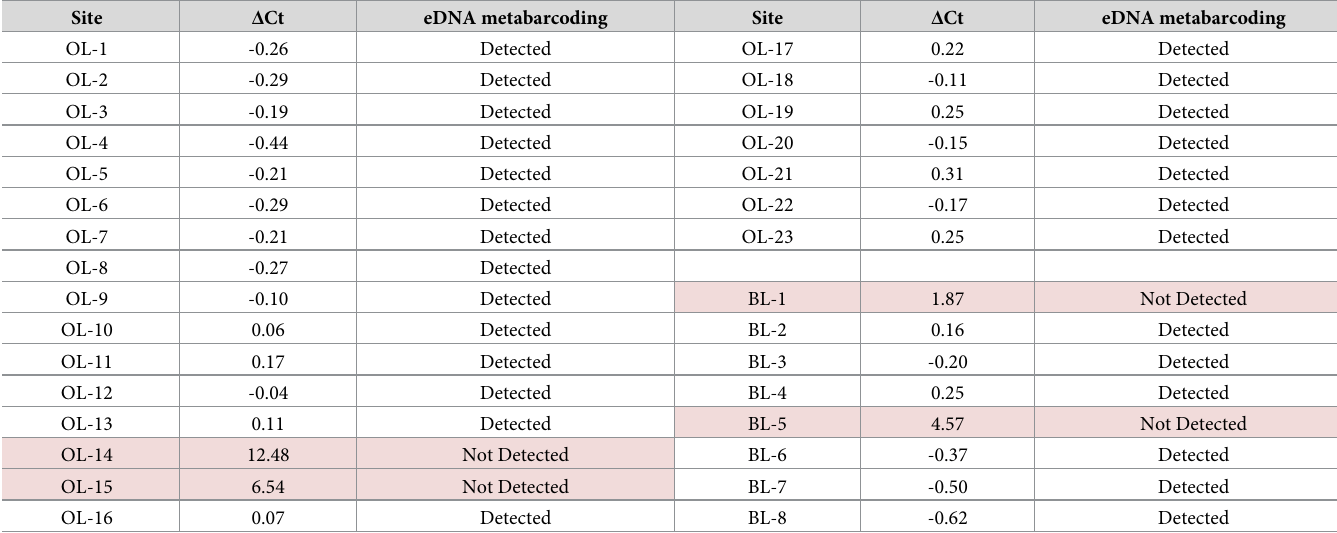
Table 3. The mean Δ Ct for PCR inhibitor tests for the extracted samples.